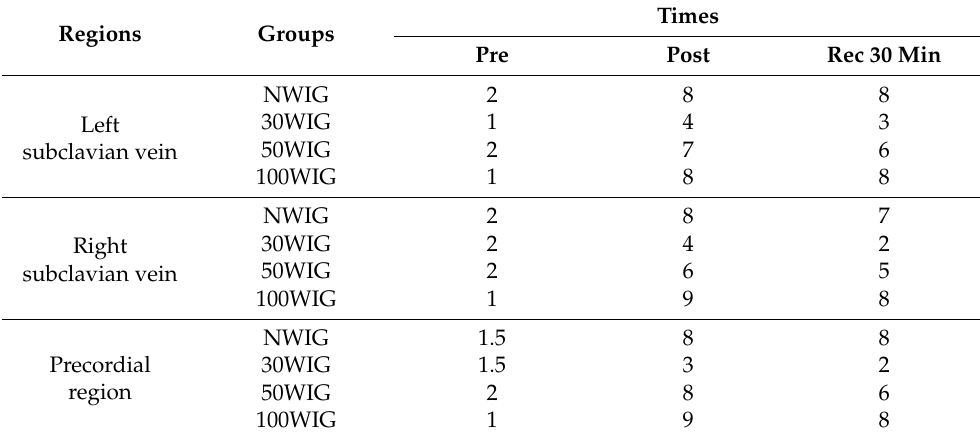
Table 6. Bubble grade in the left and right subclavian veins and precordial region. Regions Groups